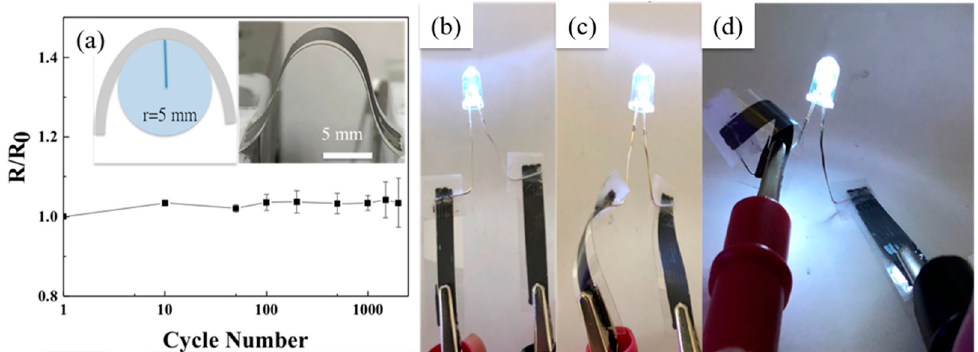
Figure 5. ( a ) The resistance increase ratio (R/R 0 ) of graphene/PVDF thin film on the PET film under the bending performance test with a radius of curvature of 5 mm. After connecting the graphene/polymer composite to an LED, the light remained bright at various degrees of bending: ( b ) flat, ( c ) bending, and ( d ) spiral shape.